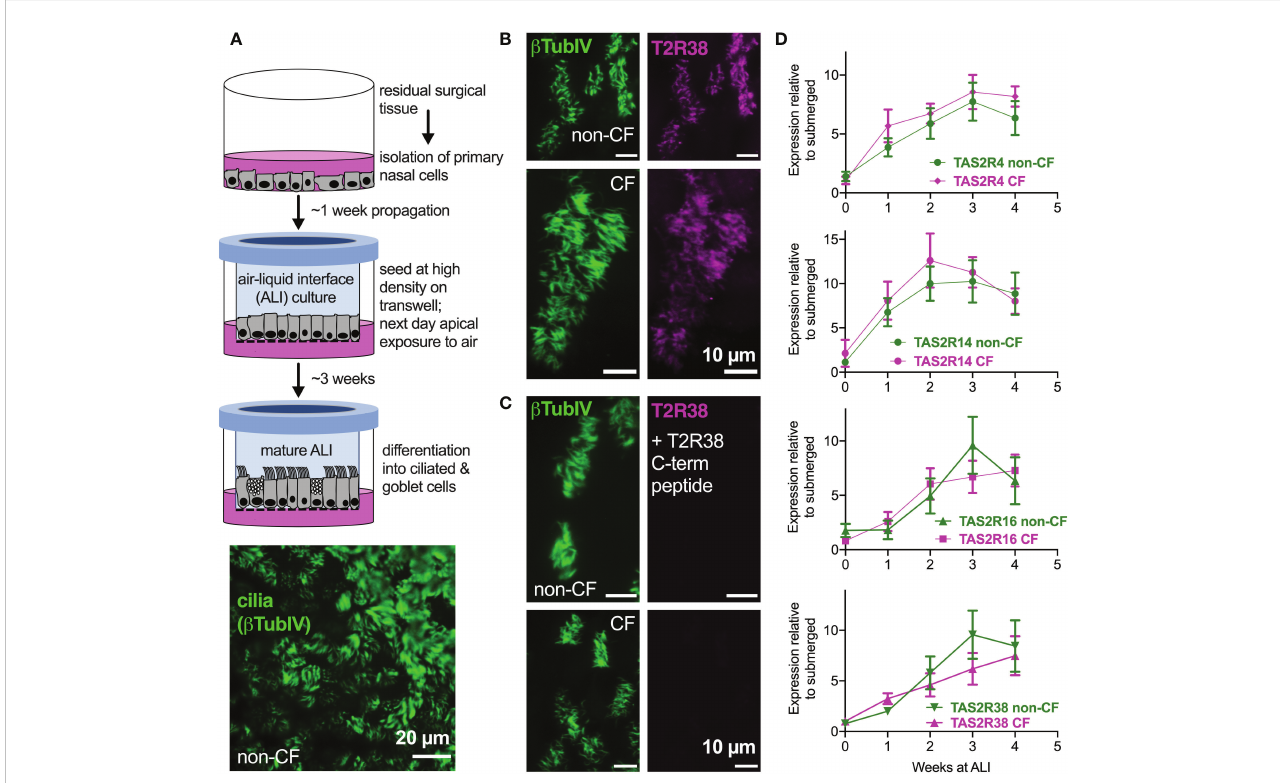
FIGURE 1 Bitter taste receptor (T2R) transcript expression in differentiated CF and non-CF primary nasal cells. (A) Air-liquid interface (ALI) culture model for differentiation of primary nasal epithelial cells (top) results in formation of motile cilia (bottom, stained with antibody against b -tubulin IV). (B, C) Nasal ALI cultures in differentiated non-CF (top panels) and CF primary nasal cells (bottom panels) express cilia-localized T238, evidenced by co-localization of b - tubulin IV. B shows immuno fl uorescence of C-terminal directed primary antibody while C shows immuno fl uorescence after primary antibody was incubated with 10-fold molar excess T2R38 C-terminal peptide prior to application on cells. Results representative of 3 independent experiments using cells from 3 patients. (D) Taqman qPCR for TAS2R4 , TAS2R14 , TAS2R16 , and TAS2R38 genes encoding cilia-localized T2R4, 14, 16 and 38 revealed no differences between CF and non-CF cells over the course of four weeks of mucociliary differentiation. Expression is normalized to housekeeping gene UBC. Results are mean ± SEM from 5 independent experiments using cells from 5 non-CF and 5 homozygous F508del CF patients. No signi fi cant differences determined by